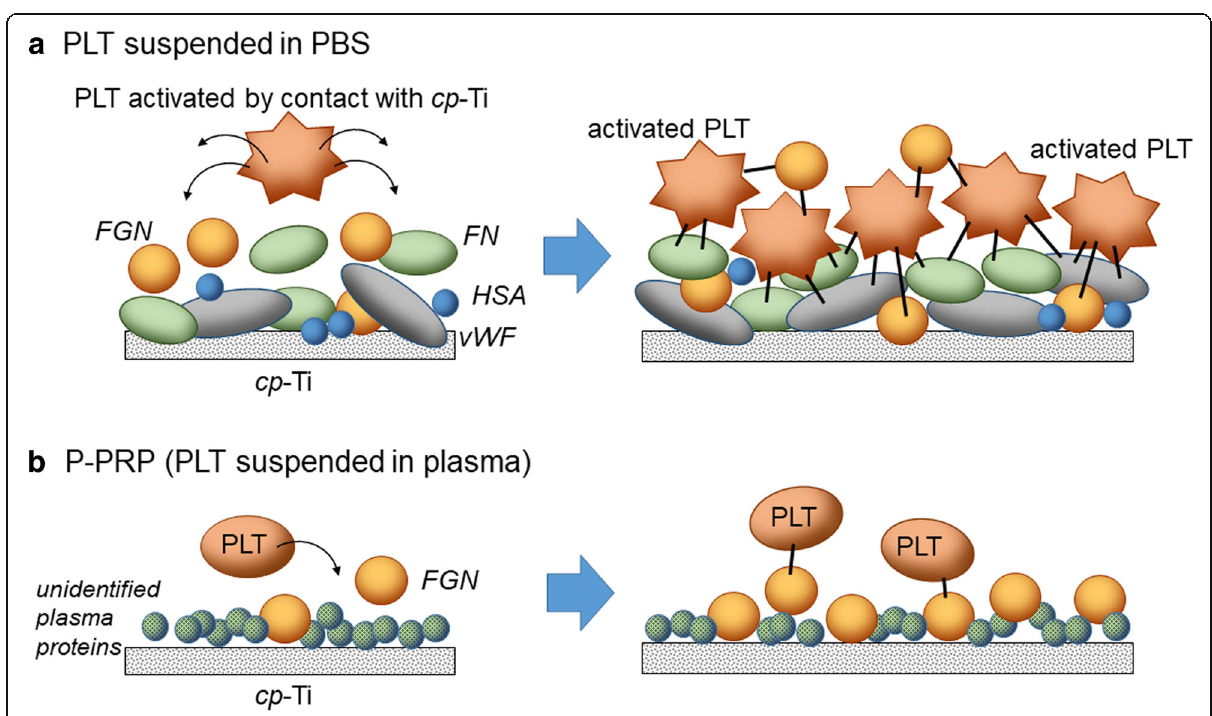
Fig. 11 Possible mechanisms of protein adsorption and platelet adhesion on cp -Ti plates. a Platelets suspended in PBS and b P-PRP. (Left and center) Time-course changes in protein adsorption and platelet adhesion. (Right) Possible relationships between adhesion molecules and their receptors expressed in platelets. cp - Ti commercially pure titanium, PBS phosphate-buffered saline, P - PRP pure platelet-rich plasma, PLT